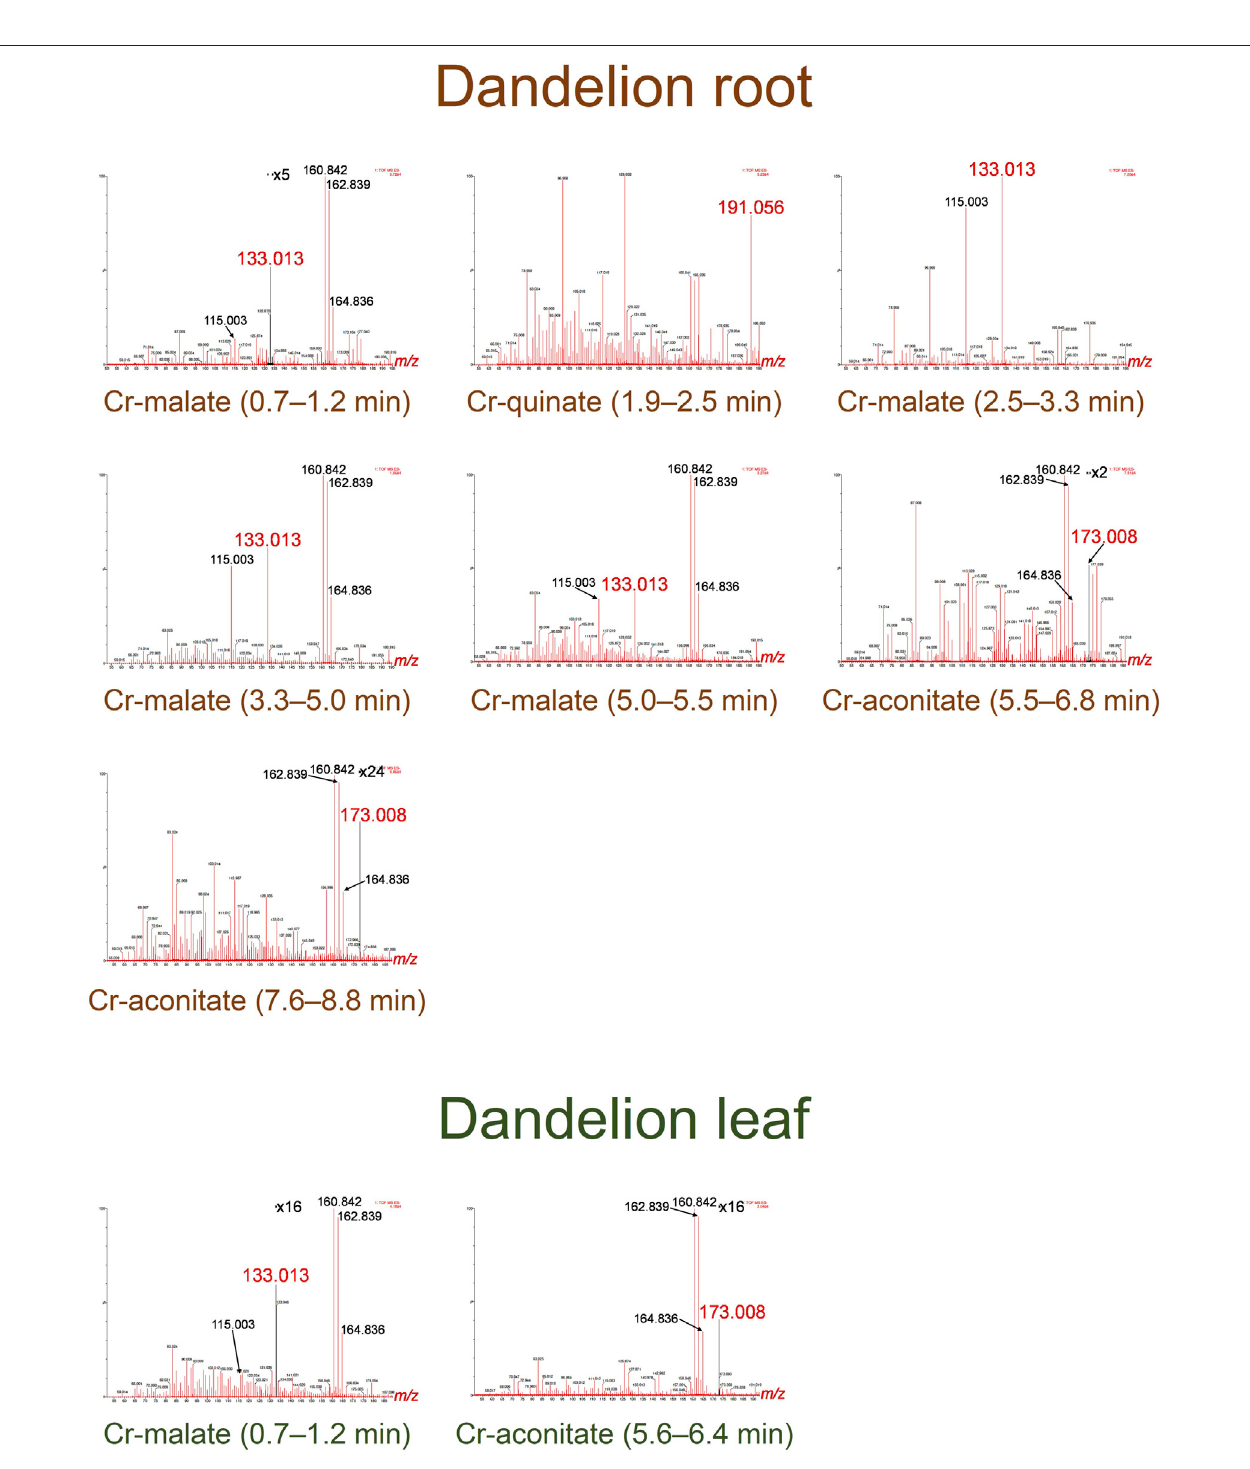
FIGURE 4 | HR-MS spectra of the Cr species eluted under the chromatographic peaks of dandelion root and leaf sap from Vranja Pe č .